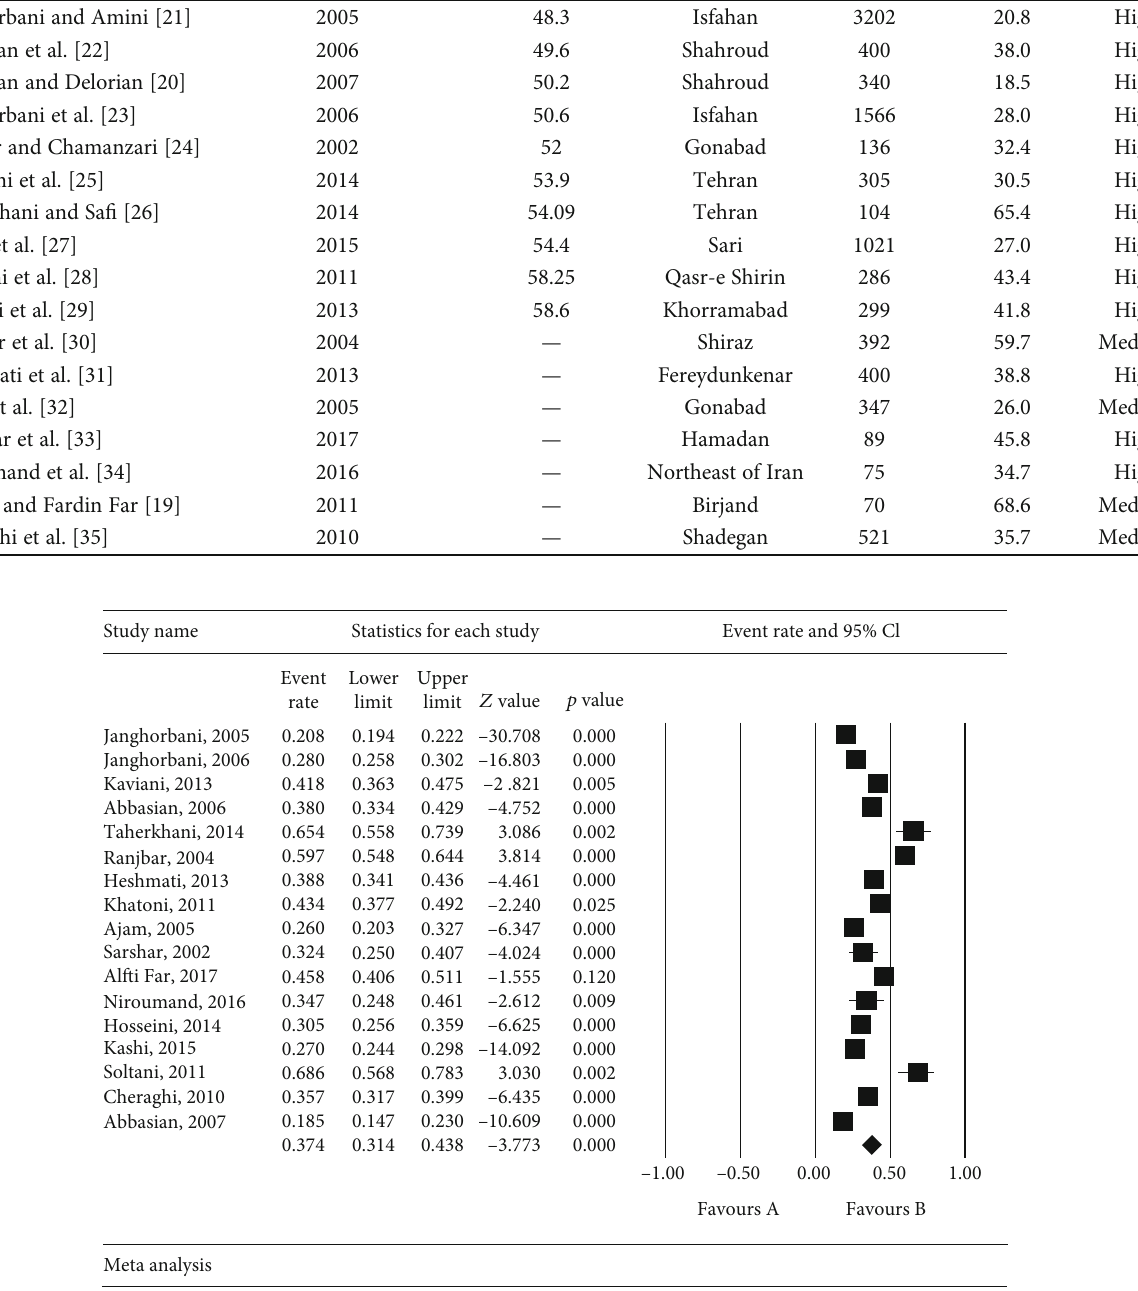
Figure 3: Prevalence of cardiovascular disease in patients with type 2 diabetes mellitus (DM) and 95% con fi dence interval in Iran. The middle point of each line shows the prevalence of cardiovascular disease in each study, and the rhombic fi gure shows the prevalence of cardiovascular disease in patients with type 2 DM in Iran for the whole